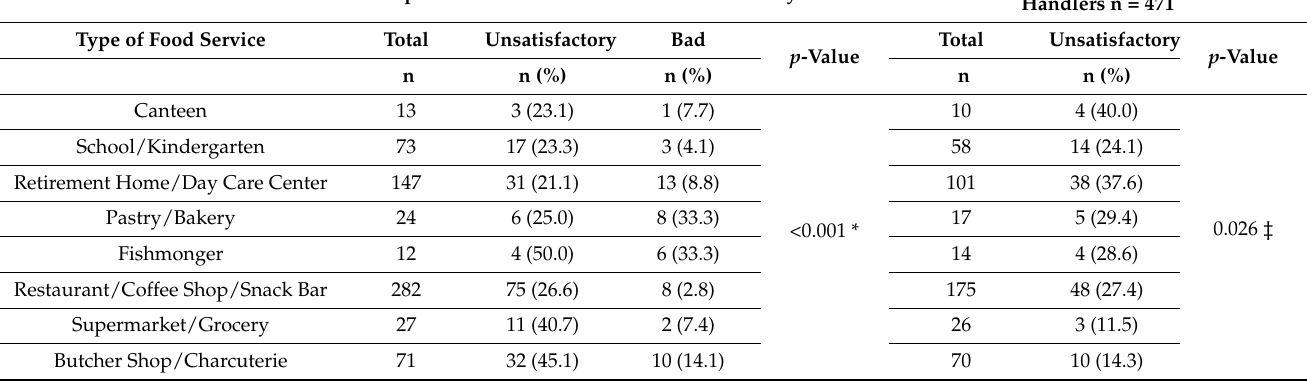
Table 1. Distribution of samples taken from hands of food handlers and from crockery/utensils according to the type of food service. Samples Taken from Kitchen Utensils/Crockery n = 649